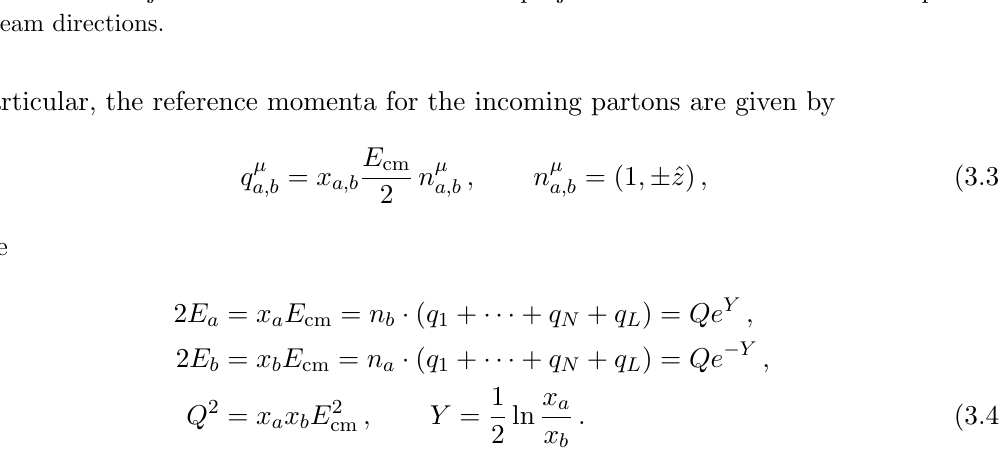
Figure 1 . The N -jettiness observable measures the projection of radiation onto N axes plus the two beam